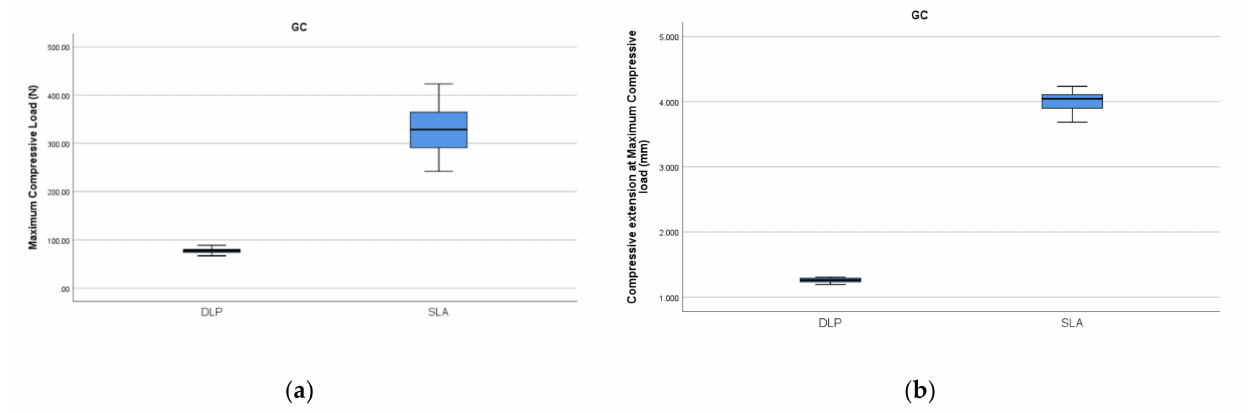
Figure 7. Boxplots of the comparisons between the CG: compressive load ( a ) and compressive extension at the maximum compressive load ( b